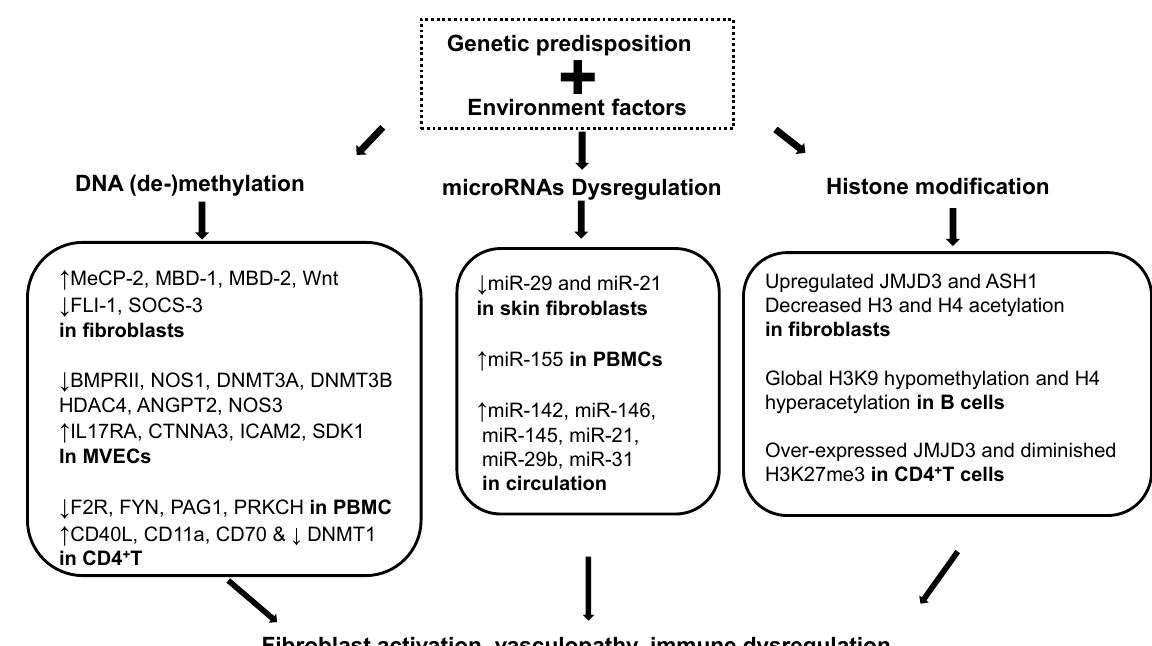
Figure 1. Possible roles of epigenetic mechanisms involved in systemic sclerosis pathogenesis. Genetic disposition and environmental factors can alter DNA (de-)methylation, histone modifications and microRNAs regulation, which can contribute to systemic sclerosis associated fibroblasts activation, vasculopathy, and immune dysregulation. Abbreviation: Methyl-CpG binding protein 2, MeCP-2; methyl-CpG DNA binding protein,MBD-1; Friend leukemia integration factor 1, FLI-1; bone morphogenic protein receptor II, BMPRII; nitric oxide synthase 1, NOS1; histone deacetylases 4, HDAC4; angiopoietin 2, ANGPT2; interleukin 17 receptor, IL-17RA; catenin alpha 3, CTNNA3; intercellular adhesion molecule 2, ICAM2; sidekick cell adhesion molecule 1, SDK1; coagulation factor II thrombin receptor, F2R; FYN proto-oncogene, Src family tyrosine kinase, FYN; phosphoprotein membrane anchor with glycosphingolipid microdomains 1, PAG1; protein kinase C eta, PRKCH; DNA (cytosine-5)-methyltransferase 1, DNMT1; 3-Deazaneplanocin A, DZNep; JMJ domain- containing protein 3 ,